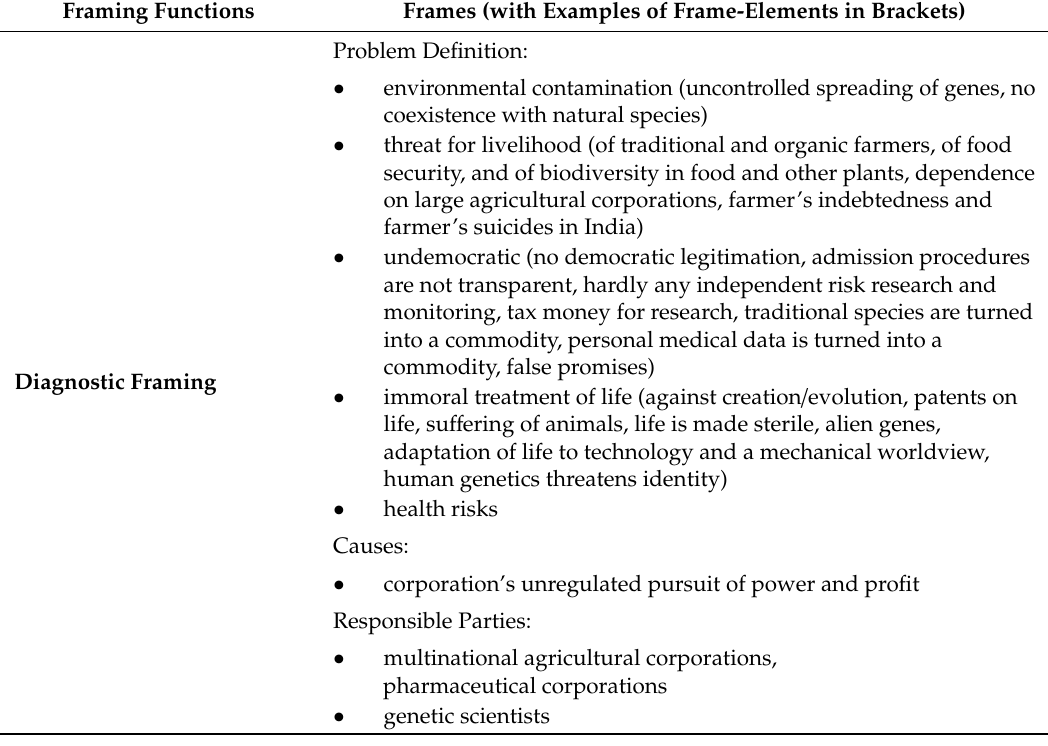
Table A1. Framing in the film Leben ausser Kontrolle